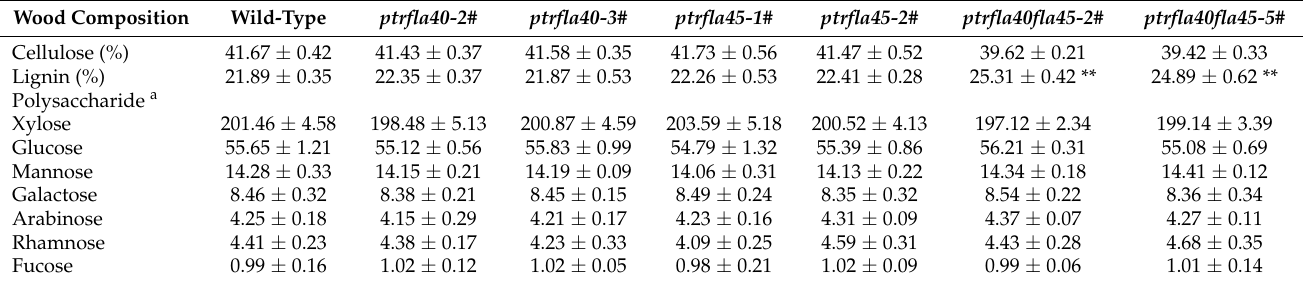
Table 1. Wood composition of wild-type and mutant ( ptrfla40, ptrfla45, and ptrfla40fla45 ) plants.